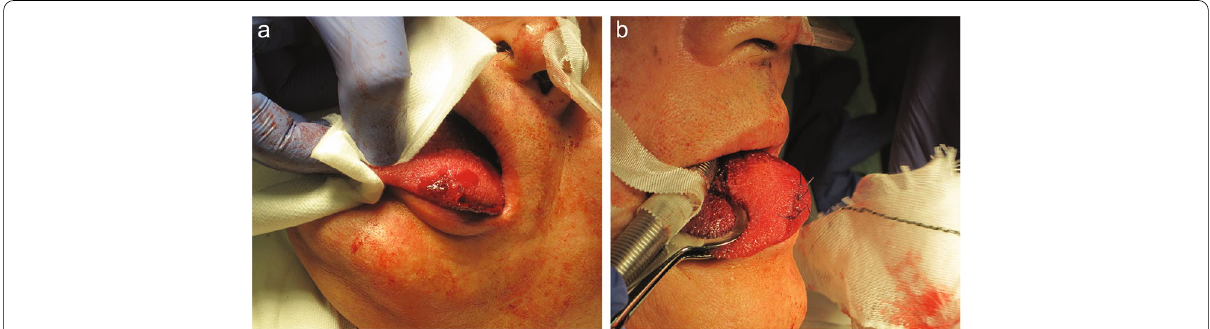
Fig. 1 Photograph of the patient’s tongue. This photograph shows the tongue bite injury on the left side ( a ) and the sutured laceration ( b